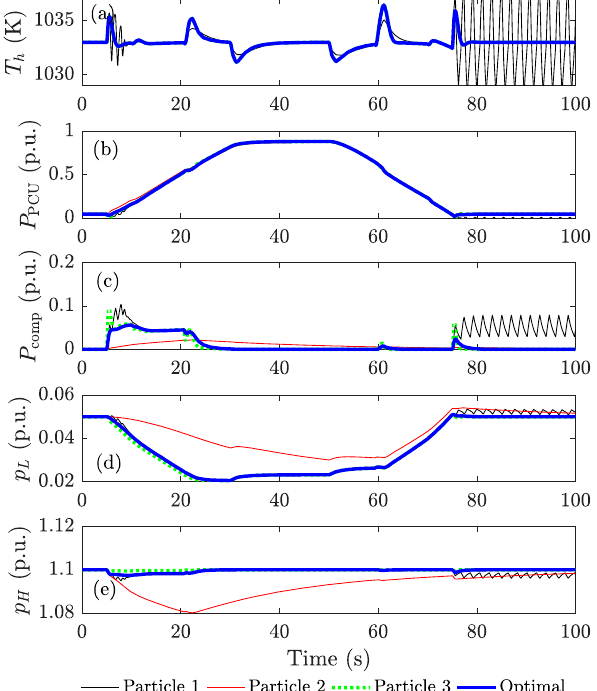
Figure 15. Simulation results with different particles (control parameters): ( a ) receiver temperature, ( b ) power generated from the PCU, ( c ) power consumed by the compressor, ( d ) gas pressure in the high pressure tank, and ( e ) gas pressure in the low pressure